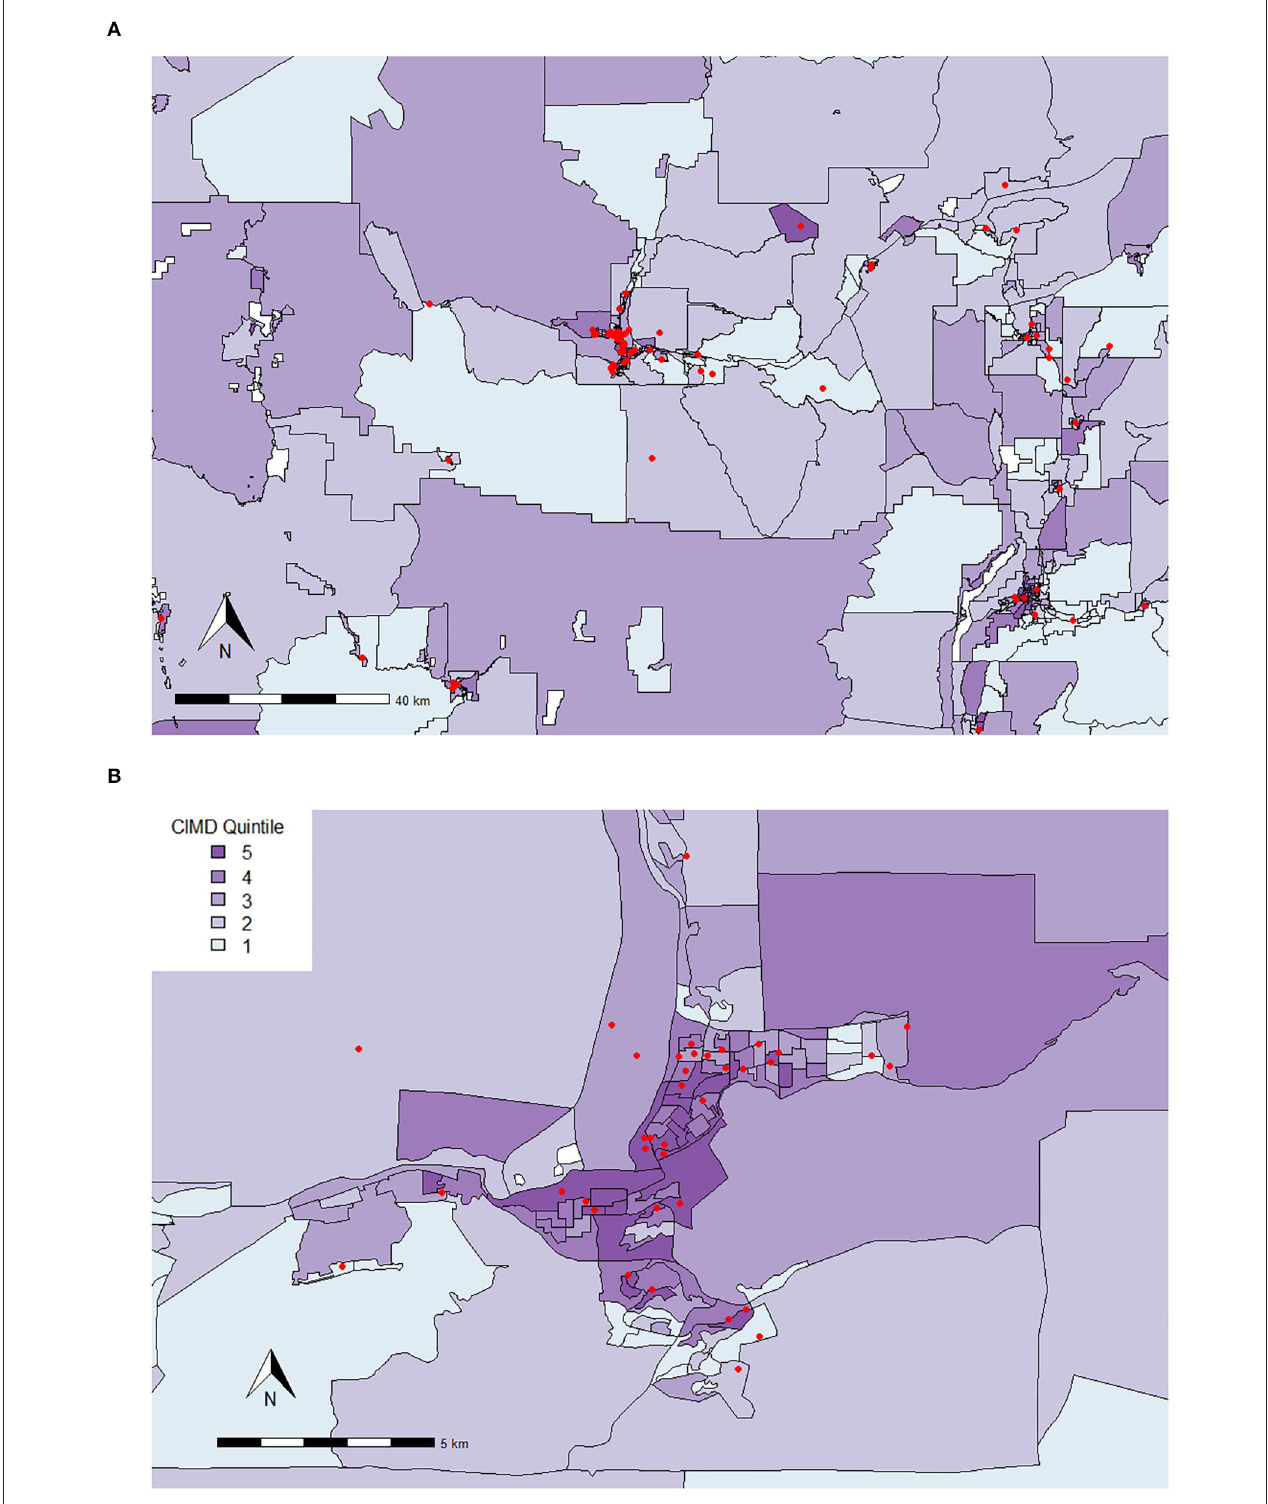
FIGURE 8 | Red dots represent locations where animals scored Unhealthy-Untreatable were surrendered from in (A) Kamloops and surrounding areas and (B) the City of Kamloops (September 1, 2016 to August 31, 2020) plotted on top of quintiles for Residential Instability (1 = least instable, 5 = most instable). The Residential Instability factor of the CIMD includes indicators such as the proportion of apartment dwellings; the proportion of persons living alone; the proportion of rented dwellings; and the proportion of population that has moved in the last 5 years. While each point shows the dissemination area of origin, it does not represent the true